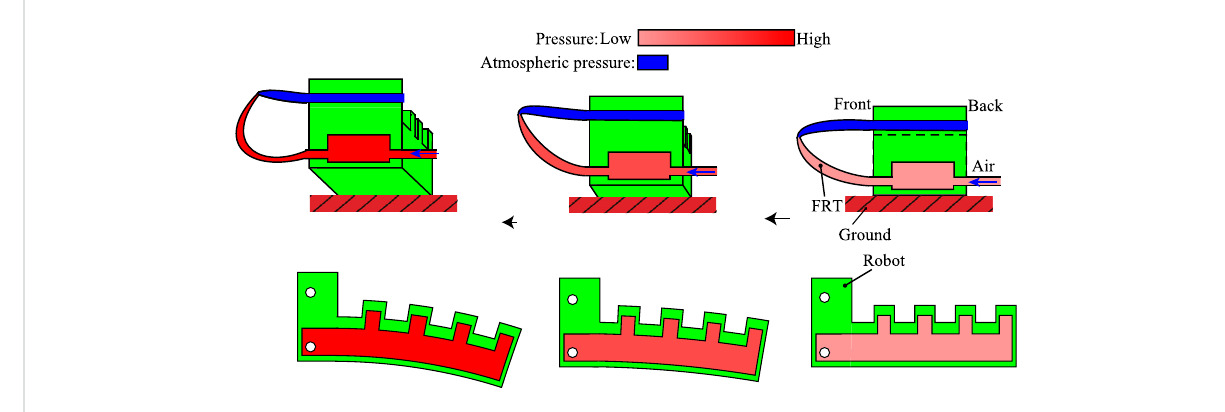
FIGURE 9 Principle of proposed robot: The legs begin to bend as the pressure of the FRT increases. The direction of bending is downward and backward, depending on the shape of the air chamber.